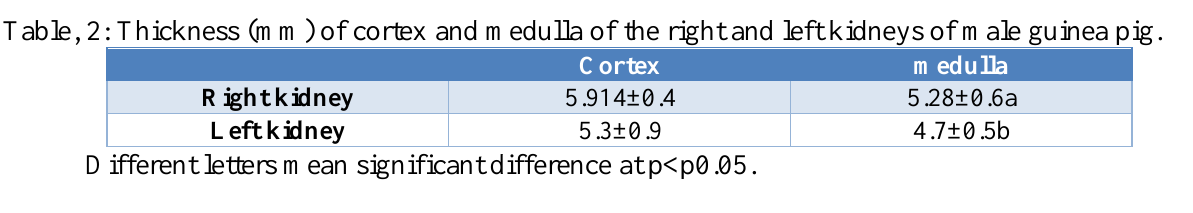
Table, 3: Diameter of renal structures in guniea pig / micrometer.